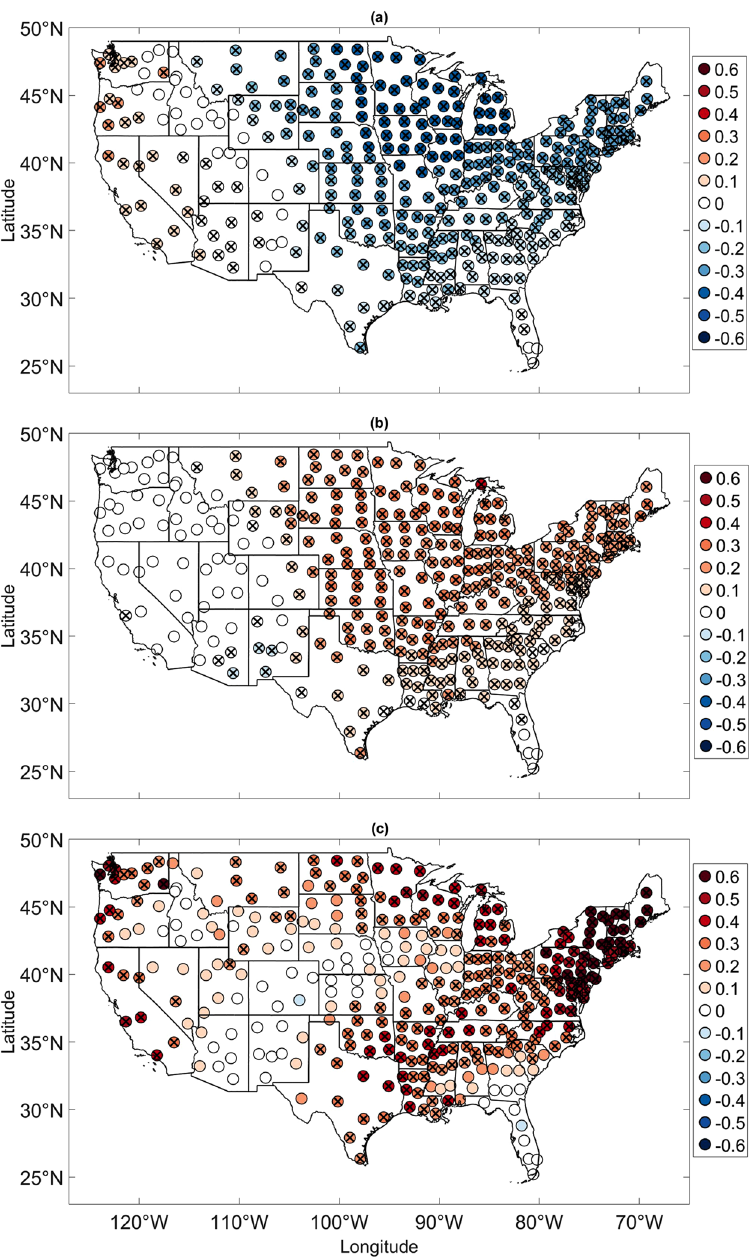
Figure 2. Strength and Trends in EP/NP index-temperature relationships. ( a ) Correlation between EP/ NP index and temperature for each climate division from 1950 to 2015. Correlation coefficients statistically significant at the 5% level are indicated by crosses. ( b ) Linear trends per year in explained variance calculated using the sliding correlation analysis. Crosses denote those trends that are statistically significant at the 5% level. ( c ) Same as ( b ) except for the explained variance calculated using the scale-averaged coherence analysis. In this case, explained variance is defined as the scale-averaged coherence multiplied by 100 because coherence by definition is the fraction of variance of one time series explained by another time series. The map was generated using MATLAB’s geoshow routine (MATLAB 2015a,